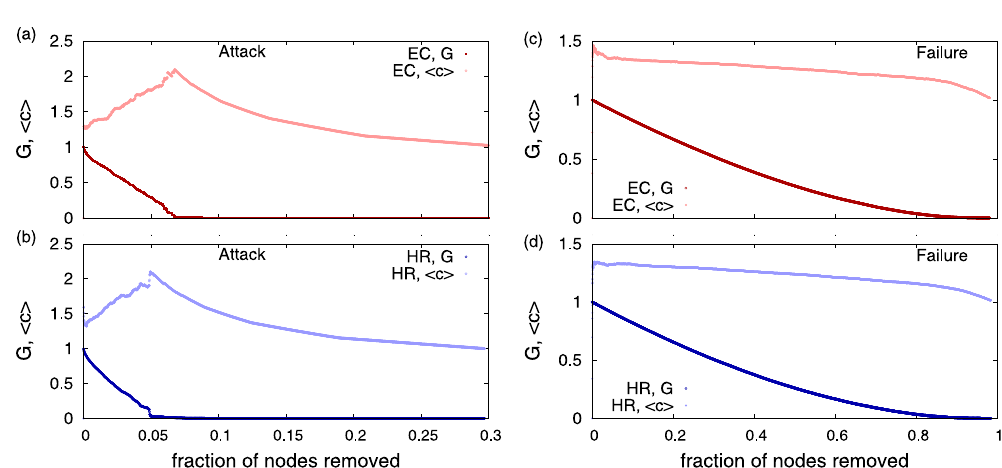
Figure 6. The structure of the network under attack: Nodes are removed in the sequence of their degrees starting from the highest degree. The plot shows the behavior of the giant component G (fraction of nodes in the largest connected component) and the average number of nodes in the clusters other than the giant component 〈 c 〉 , with increasing fraction of removed nodes, for ( a ) EC and ( b ) HR. The structure of the network under random failure: Nodes are removed randomly. Results are shown for ( c ) EC and ( d ) HR networks. The networks are destroyed very quickly by targeted node removal (attack), compared to random node removal (failure). The results are for networks aggregated over